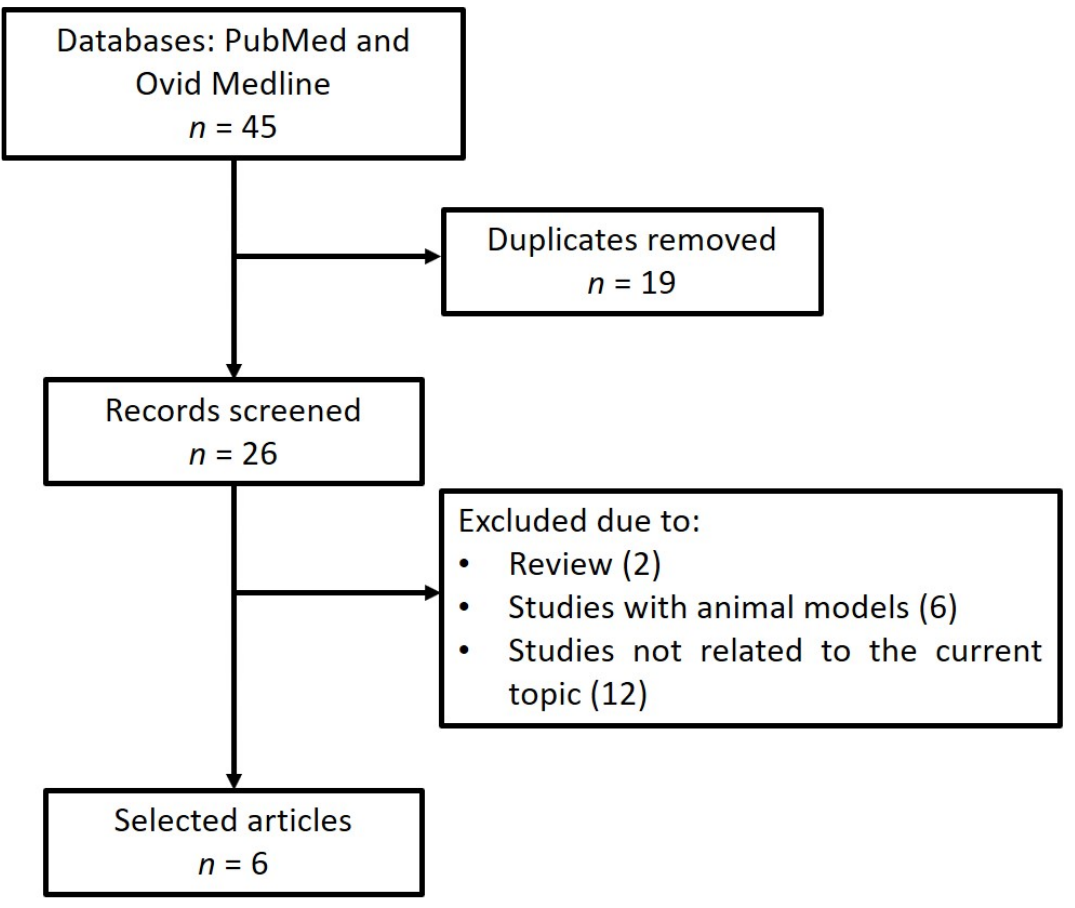
Figure 3. PRISMA flow diagram of study selection for idiopathic scoliosis and miRNA dysregulation. Table 3. Selected papers regarding idiopathic scoliosis and alteration of microRNAs.